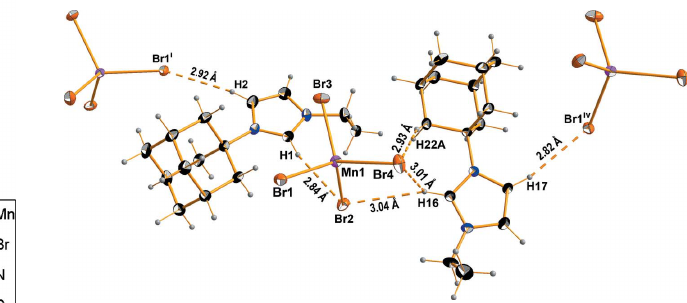
Figure 3 Selected hydrogen bonds between the cations and anions in the crystal